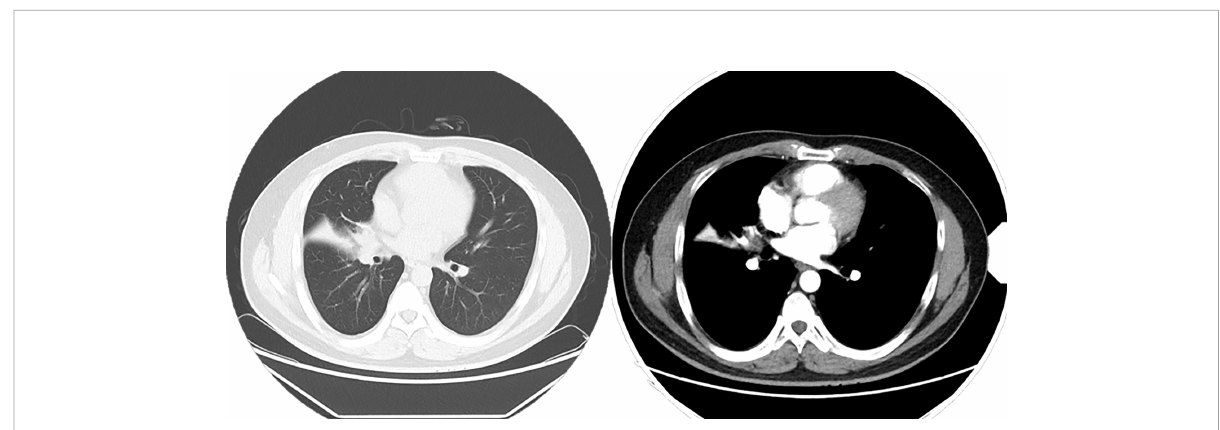
FIGURE 4 Chest CT enhancement scan: Soft tissue nodule is seen at the right hilum, measuring approximately 2.0 × 1.7 cm, and mild enhancement is seen on the right lung middle lobe atelectasis, with a patchy hyperdense shadow and right lung middle lobe bronchus occlusion. A ground- glass nodule shadow is seen in the dorsal segment of the lower lobe of the right lung, measuring 7 × 5 mm, approximately anteriorly. An enlarged lymph node shadow is seen in the right hilum, approximately 1.0 cm in